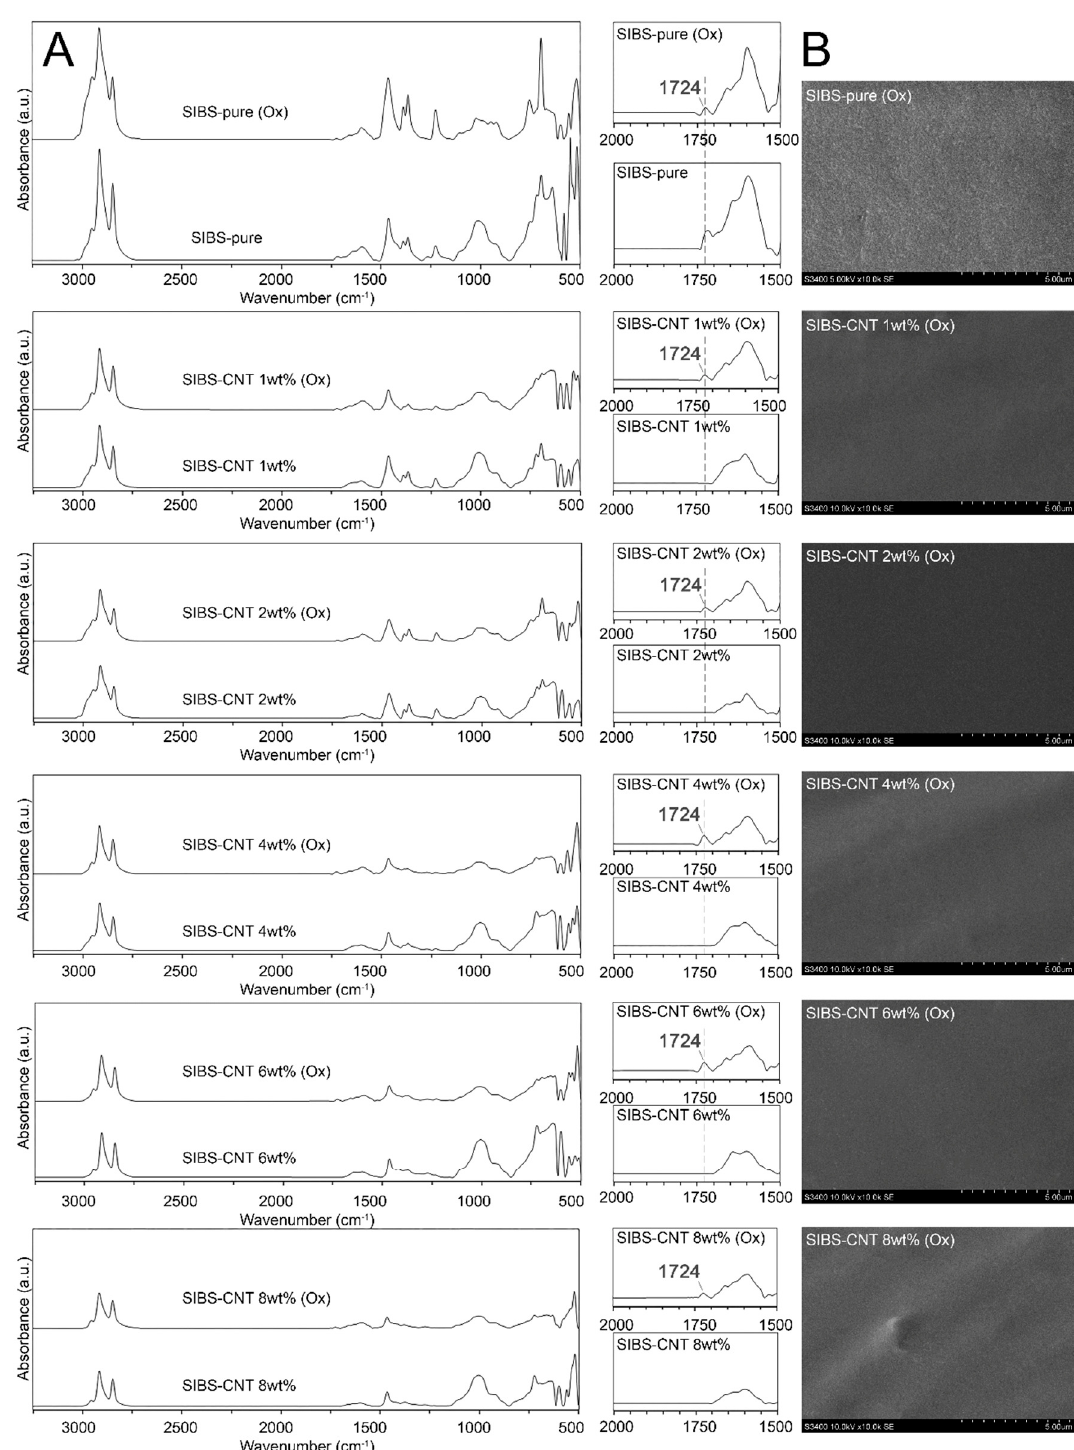
Figure 9. ( A ). SEM images of the surface of intact and CNT-modified SIBS films after 14 days of oxidation stress. ( B ). FTIR spectra of intact and CNT-modified SIBS films before and after 14 days of oxidation stress.